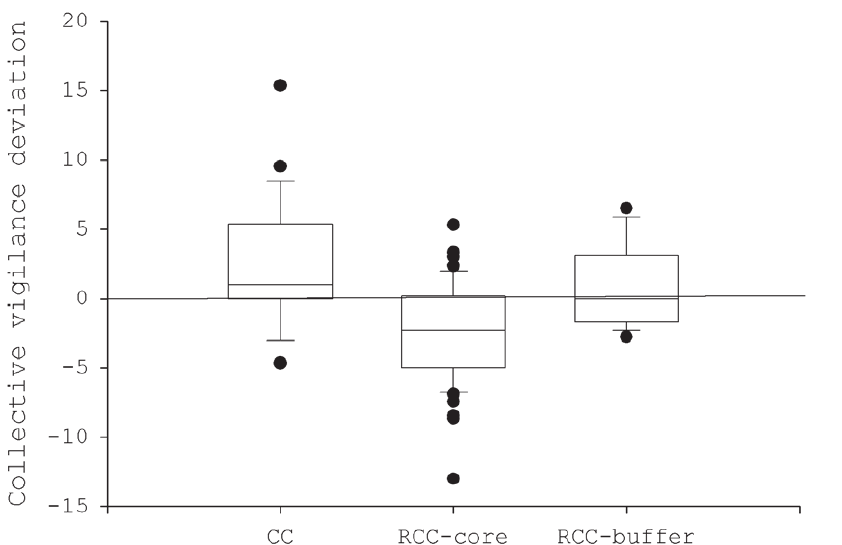
Figure 2. Comparisons of observed and expected collective vigilance between adults in two crane species. Collective vigilance was calculated using the two adults of each flock. A positive contrast value indicates coordinated vigilance while a negative value indicates synchronised vigilance (CC: common crane; RCC-core: red-crowned crane in the core zone; RCC-buffer: red-crowned crane in the buffer zone).